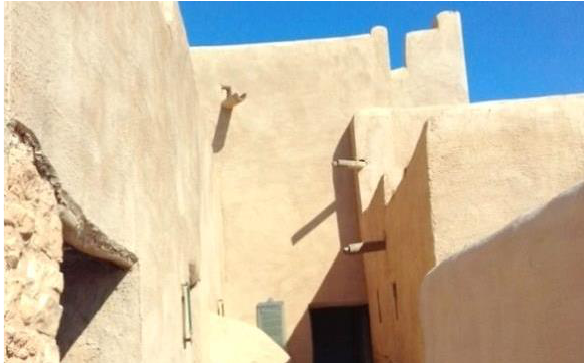
Figure 1. Iberian City-S.VI a.C., Calafell, Catalunya. Photo: César